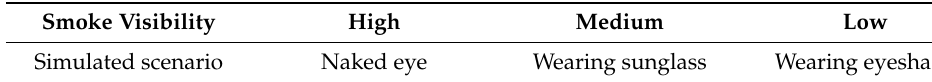
Figure 3. Height and depth of the riser. Table 1. Test scenarios.